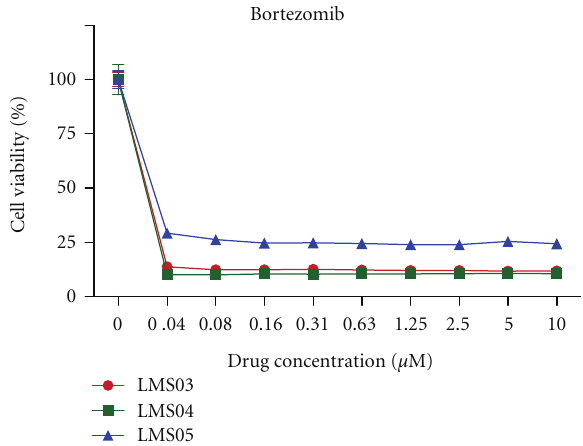
Figure 5: In vitro cell viability of LMS cell lines treated with borte- zomib. LMS03, LMS04, and LMS05 were exposed to bortezomib at concentrations ranging from 0 to10 μ M. Cell viability was assessed 72h after exposure to drugs using WST-1 assays and experiments were performed in